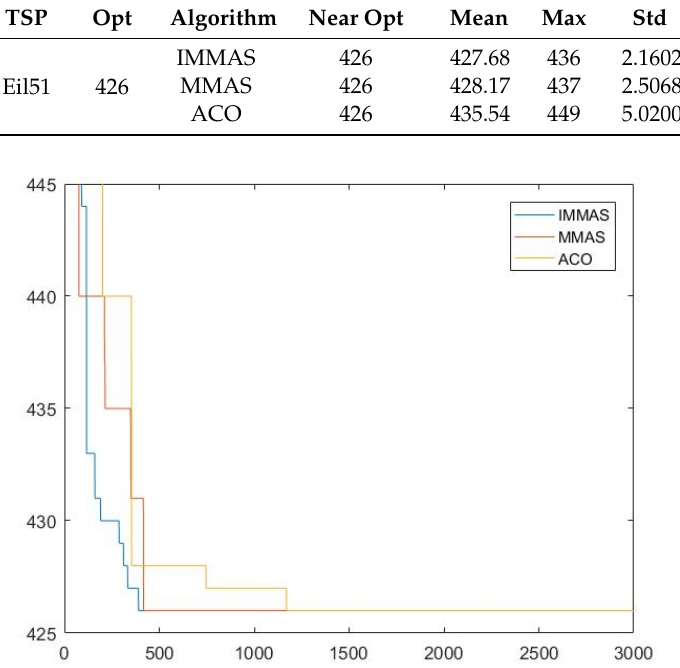
Figure 6. Route distance comparisons per each iteration from the best iteration of each algorithm.